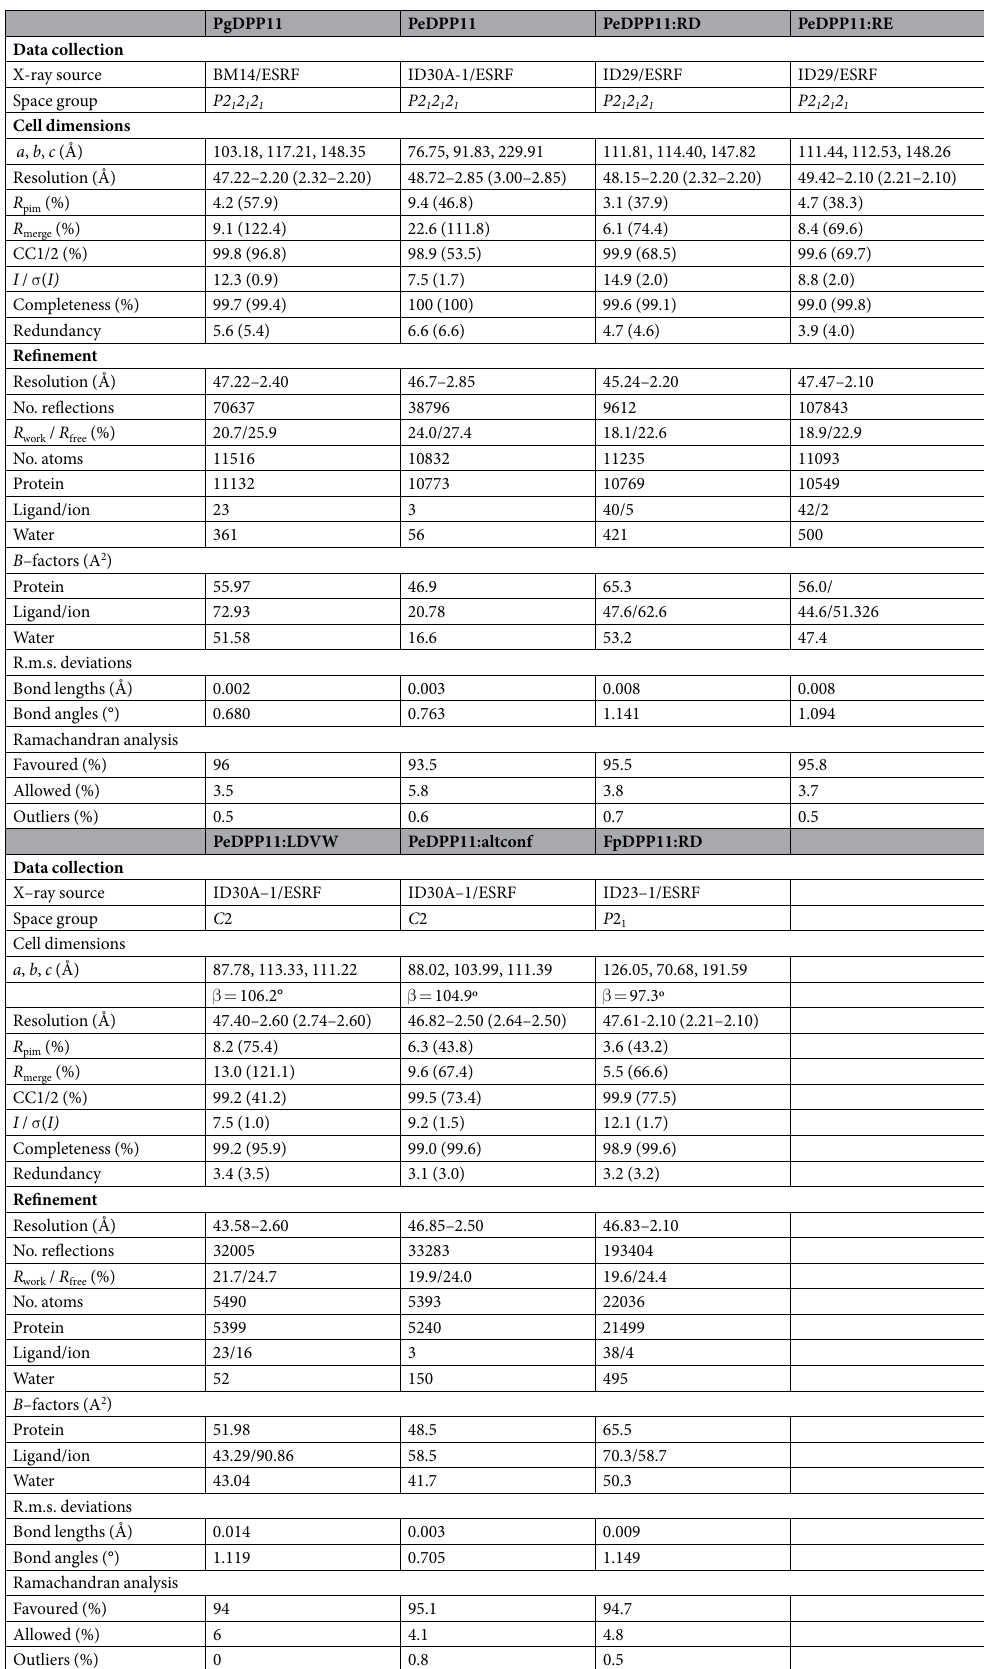
Table 1. Data collection and refinement